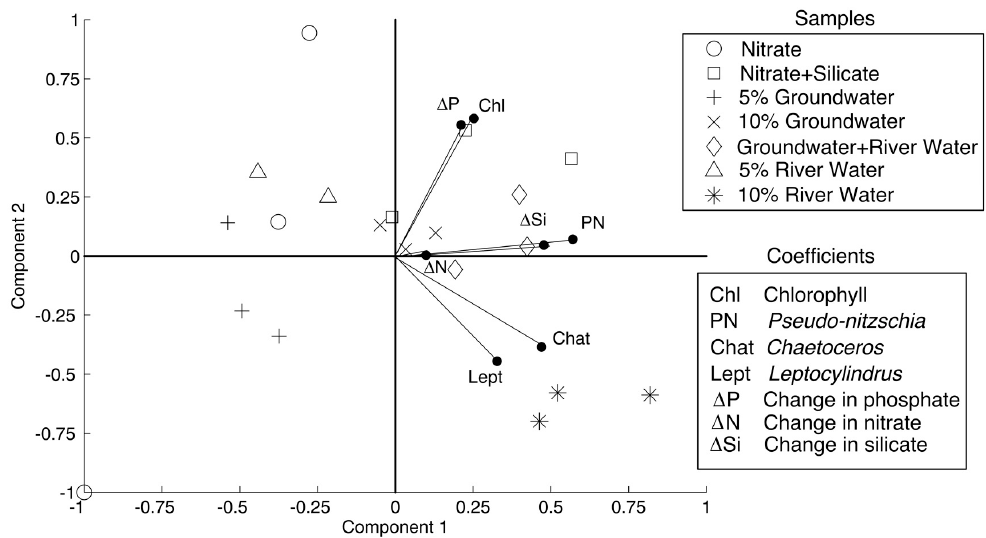
Figure 4. Results of the principal component analysis (PCA). Components 1 and 2 accounted for 41% and 23% of the variability respectively.